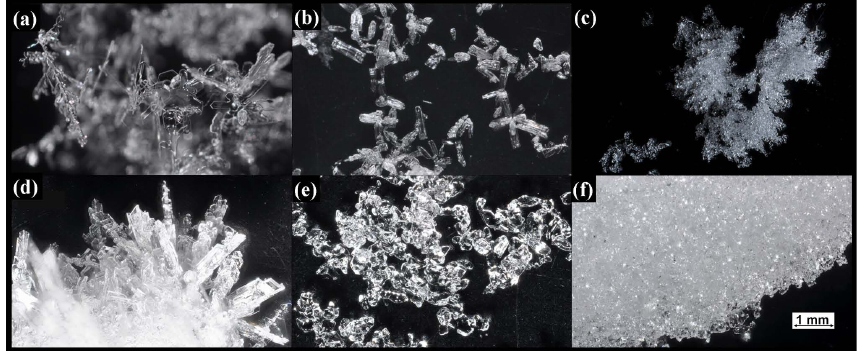
Fig. 6. The main snow types observed at Summit in May and June 2011, from stratigraphic inspections down to about 80cm: (a) stellar dendrites (PPsd), (b) columns (PPco), (c) rime (PPrm), (d) surface hoar (SH), (e) faceted rounded particles (RGxf), and (f) wind-packed particles (RGwp). All pictures were taken in the Summit clean air sector between 15 May and 20